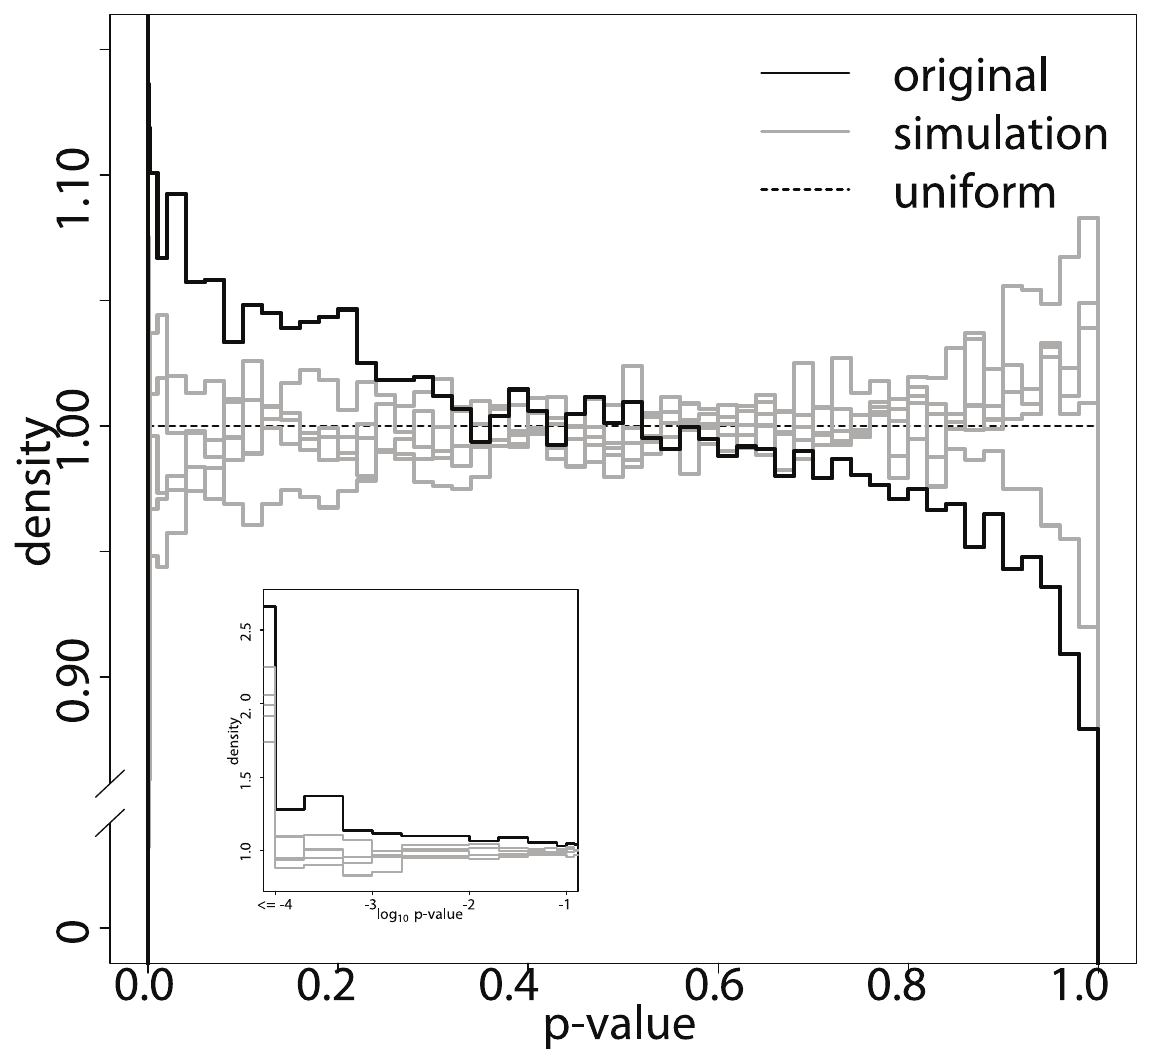
Figure 4. ImAP p-value distribution. Distribution of the p-values of the original data (black) and five simulations under the null hypothesis of no allelic incompatibilities (grey). The y-axis is concentrated on the interesting area of high density. The inset shows a zoom on the small p-values in log 10 scale.